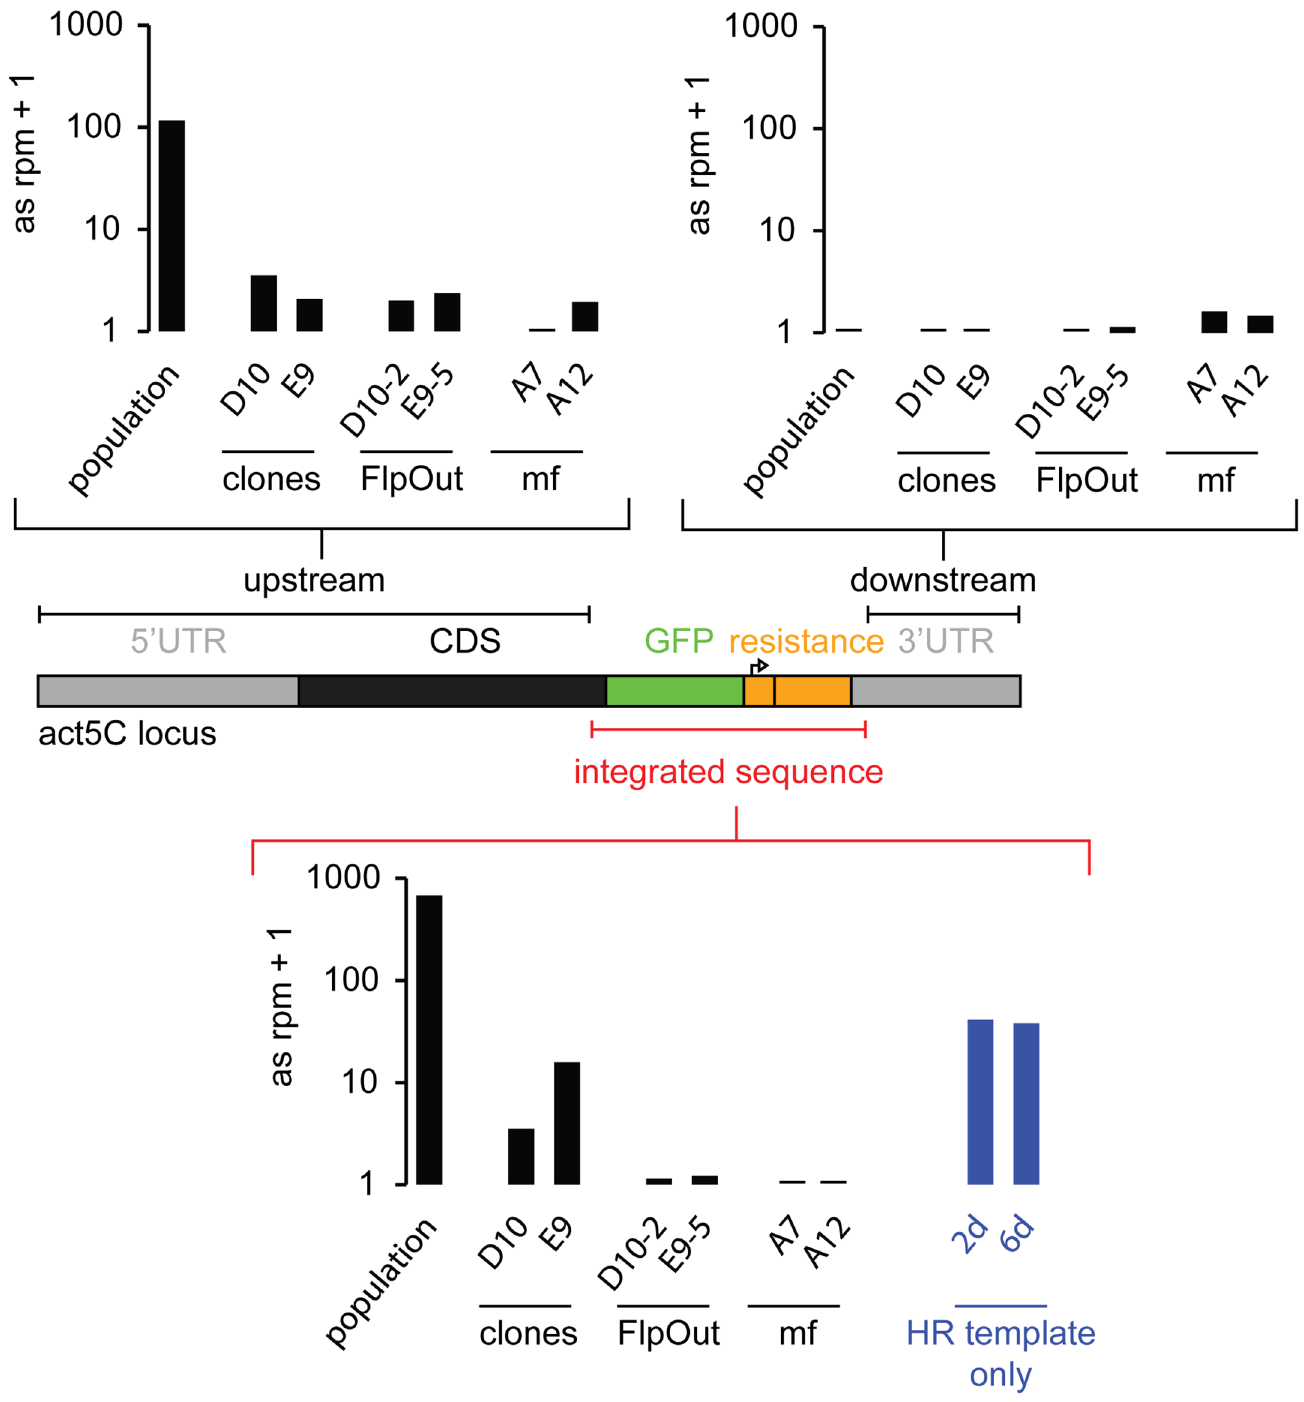
Fig 4. Quantification of the siRNA strength at the act5C locus for different cell lines. SequencedsiRNAs were mappedto the modifiedloci and antisensereads (only) mappingeither to the upstream or downstrem regionof the integrated sequenceor the HR donor were summed up and normalizedto genomematchingreads and length of the sequenceregion. (mf = marker-free tagged cell lines, FlpOut = FlpOut cell lines).